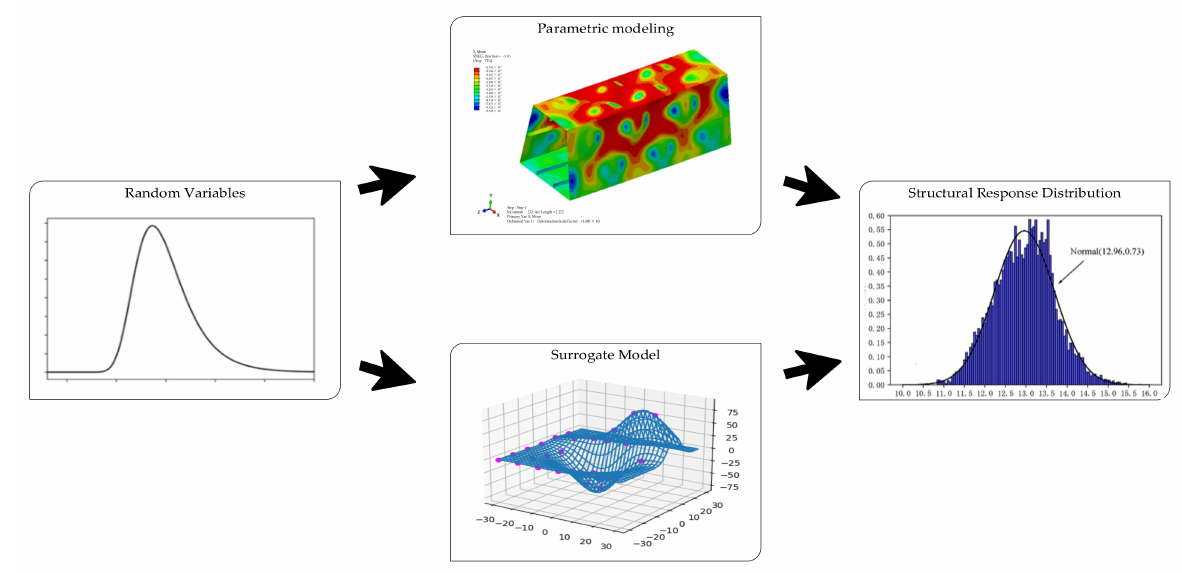
Figure 4. Surrogate model schematic diagram.